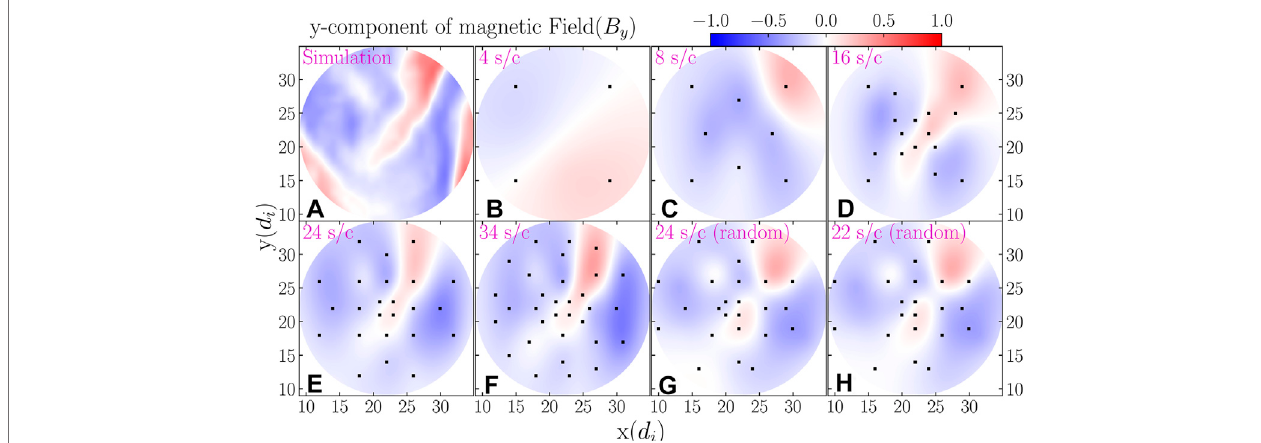
FIGURE A1 | Same as Figure 4 , but for B y , the y -component of the magnetic fi eld.